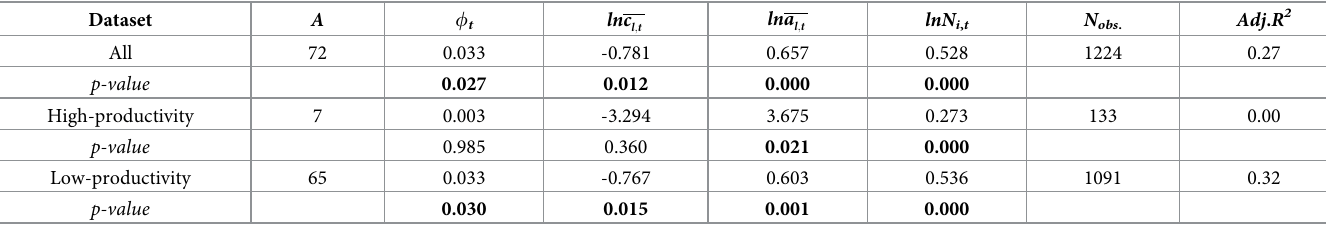
Table 6. Parameter estimates for the productivity model of super ties for n i , t / h n i i . Dataset